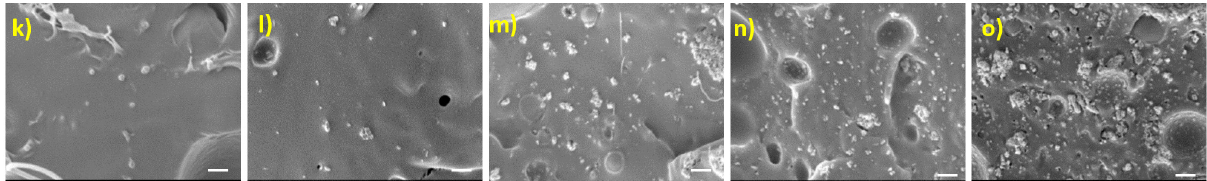
Figure 1. SEM images of pure nHA powder at ( a ) 10,000 × magnification, scale bar = 1 µ m; ( b ) 40,000 × magnification, scale bar = 0.5 µ m; and ( c ) 20,000 × magnification, scale bar = 0.1 µ m. nHA suspended in aqueous solution at ( d ) 0.5 µ m and 50,000 × and ( e ) 0.1 µ m and 100,000 × . SEM images of PLLA/nHA nanocomposites ( f ) PLLA, ( g ) PLLA/nHA 1 wt%, ( h ) PLLA/nHA 5 wt%, ( i ) PLLA/nHA 10 wt%, and ( j ) PLLA/nHA 20 wt%. SEM images of PLLA/COC10-nHA nanocomposites ( k ) PLLA/COC10, ( l ) PLLA/COC10-nHA 1 wt%, ( m ) PLLA/COC10-nHA 5 wt%, ( n ) PLLA/COC10-nHA 10 wt%, and ( o ) PLLA/COC10-nHA 20 wt%. Nanocomposites. ( f–o ) Scale bar = 1 μ m and the images